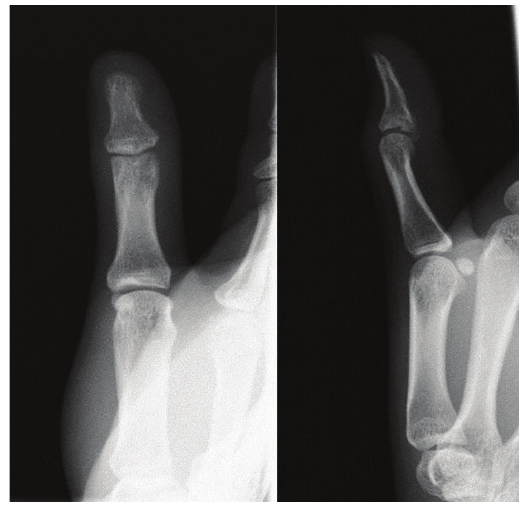
Figure4:Theplainradiographat3monthsaftersurgeryshowsbony union of the avulsion